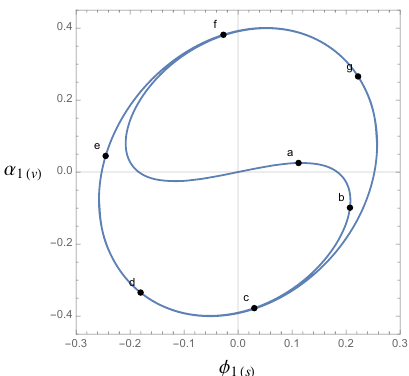
Figure 4. The behaviour of α determining certain expectation values as a function of φ 1 , ( v ) for the symmetric BPS solutions, for the N = 1 ∗ equal mass model. The labelled black dots (a)-(g) correspond to the solutions given in figure